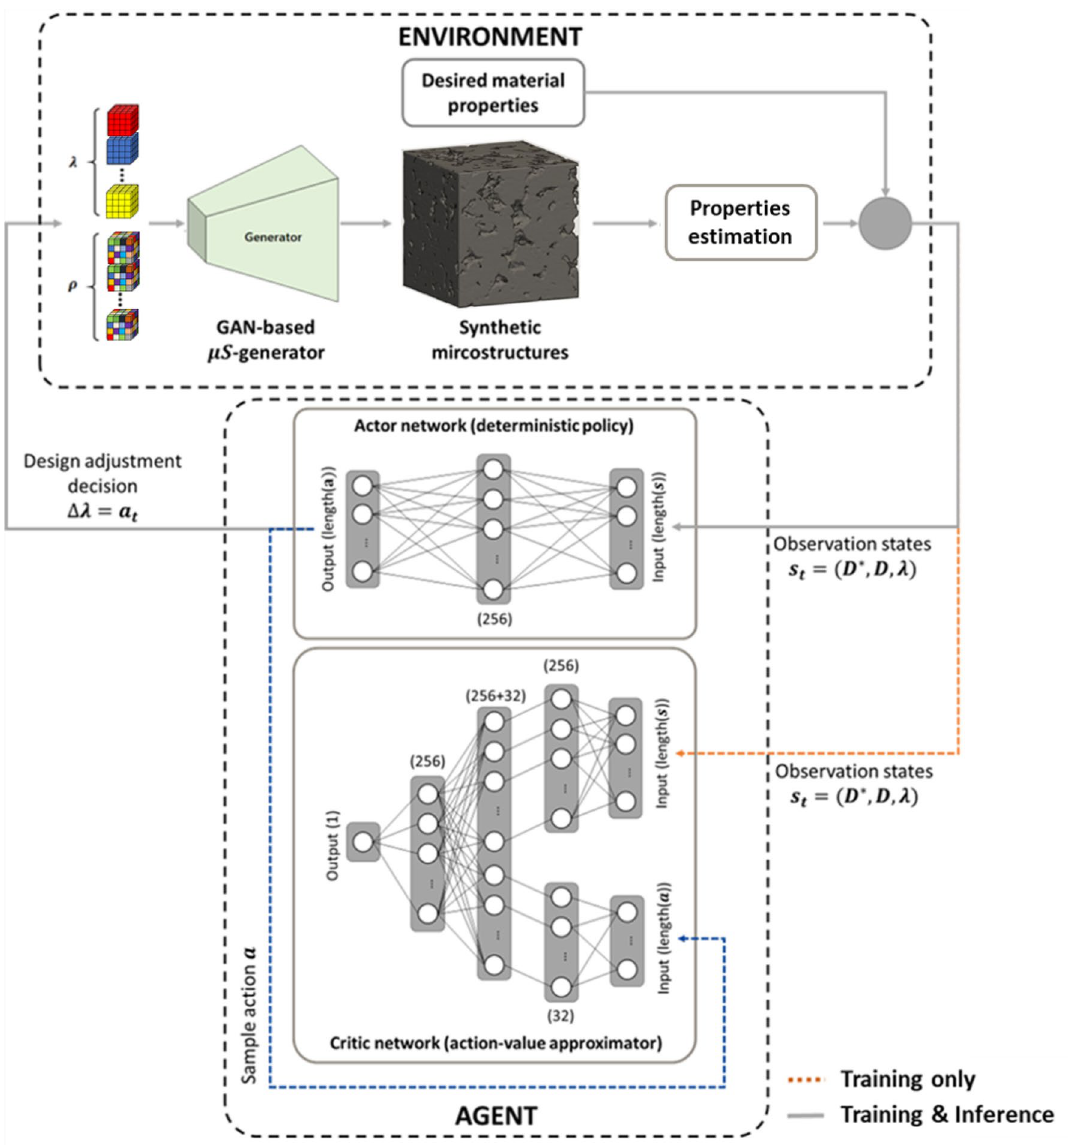
Figure 3. A schematic overview of the morphology control via an AC model. The design problem is formulated as a sequential process, adjusting global parameters at each step so that the synthetic microstructure transforms the morphology as desired. During the training process, actor network repeatedly gives design decisions based on its policy to interact with the environment . Physical properties of synthetic microstructures are computed in the environment and given as feedback to both actor network and critic network . The critic network then evaluates how successful the actor network ’s action was in conforming the targeted properties. Finally, the actor network utilizes the evaluation from the critic network to adjust its policy in order to generate synthetic microstructures with physical properties closer to the targeted ones. Once the training is finished, the critic network is discarded and only the actor network is retained to perform the design